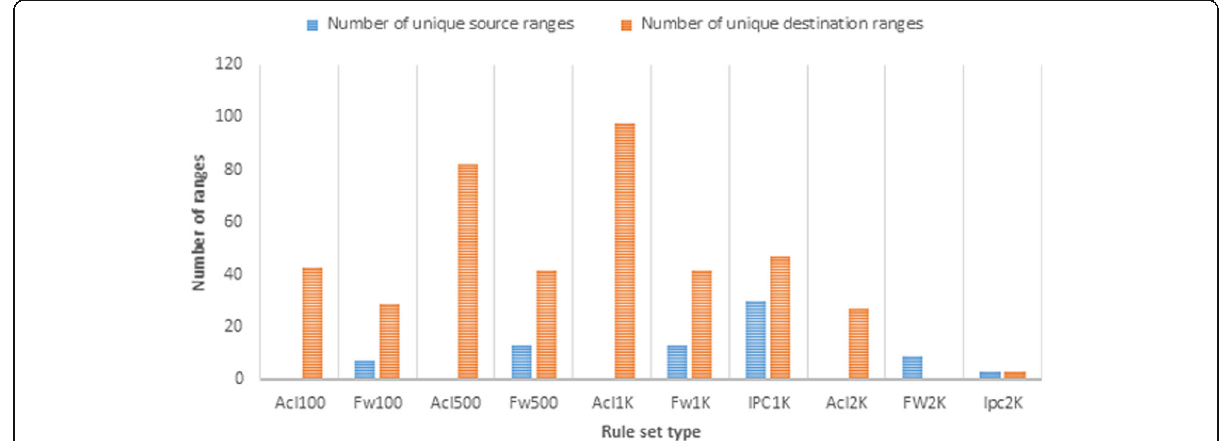
Fig. 9 The number of unique ranges for source and destination ports of ten different rule